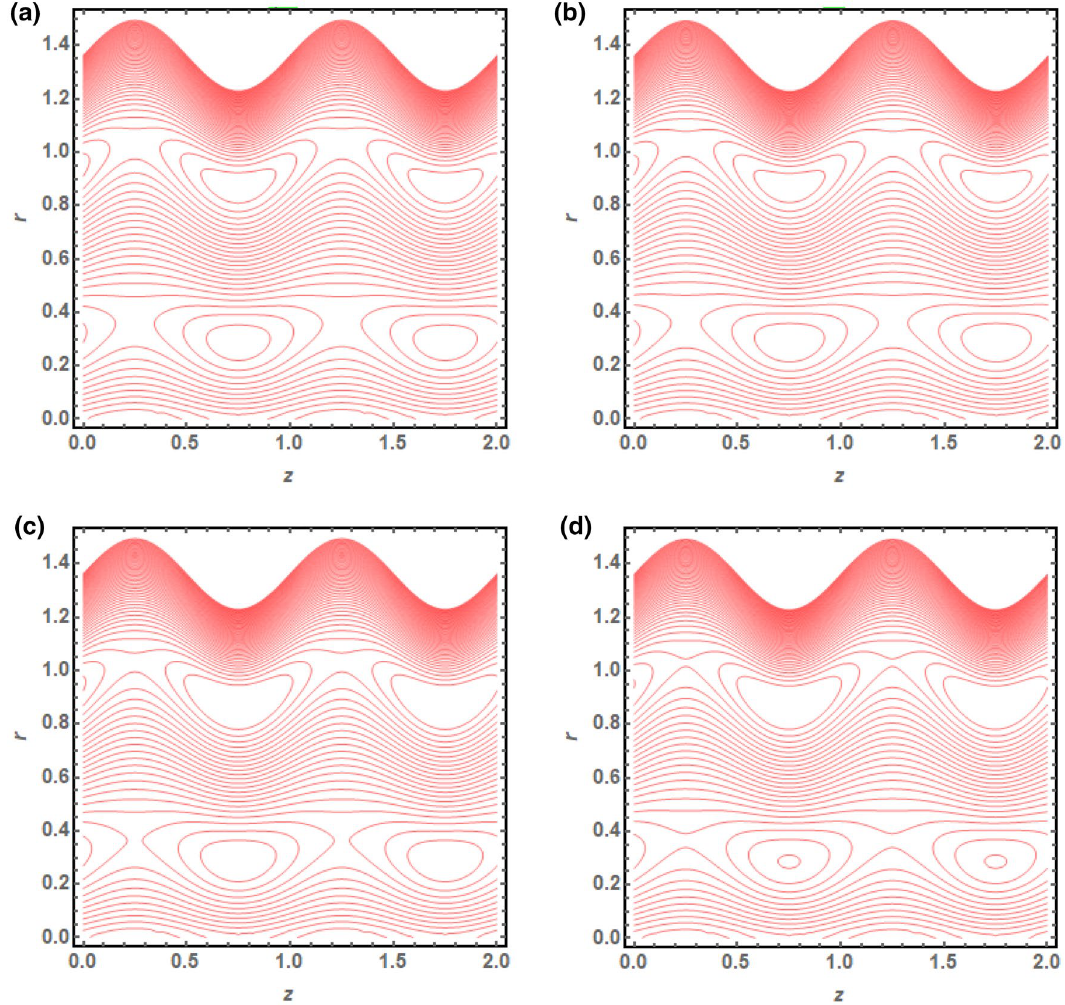
Figure 5. ( a ) Streamline plot for Q = 0.01 . ( b ) Streamline plot for Q = 0.03 . ( c ) Streamline plot for Q = 0.05 . ( d ) Streamline plot for Q = 0.07